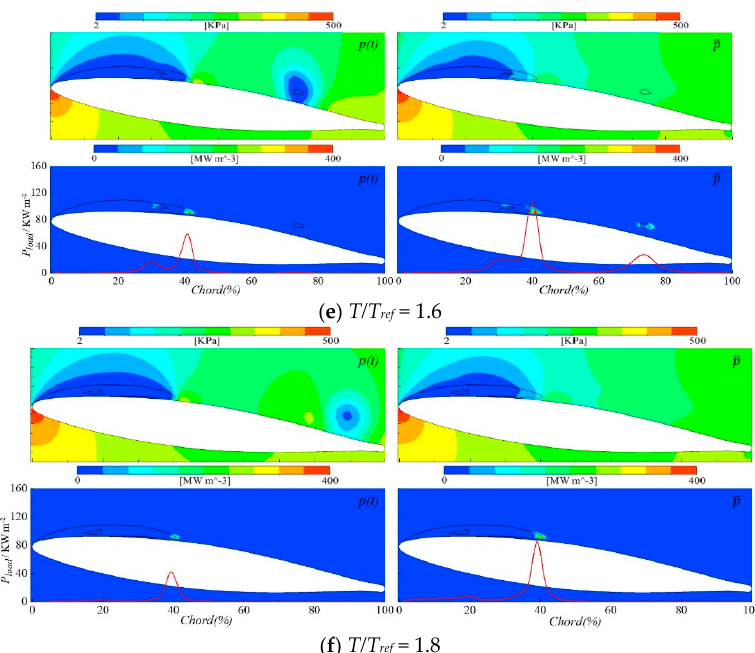
Figure 7. Contours of p(t) ( top left ), p ( top right ), P den and amplitude of P load along the chord ( bottom left and right ) obtained using p(t) ( left ) and p ( right ). Red lines showing the value of the power load on the surface along the chord. Black isolines of α v = 0.1 show the locations of the main vapor cavities at each instant.